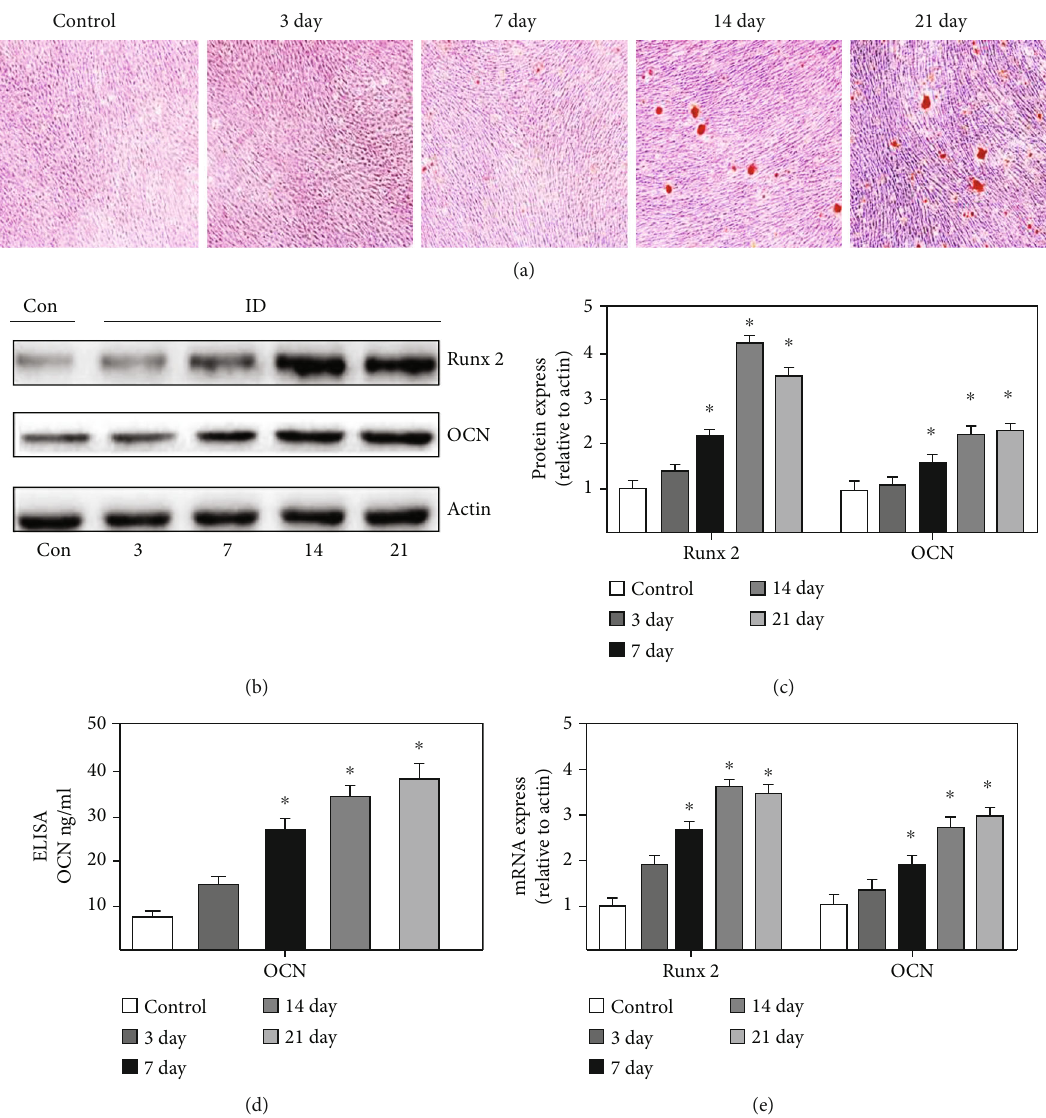
Figure 1: Induction time of osteogenic precursor cells. (a) Mineralization was analyzed through alizarin red staining. (b) The protein expression of Runx2 and OCN was measured through western blotting. (c) The protein expression of Runx2 and OCN was analyzed. (d) The level of OCN was measure with ELISA. (e) The mRNA expression of Runx2 and OCN was detected. Compared with the control group, ∗ P < 0 : 05 . MC3T3-E1 was used in these